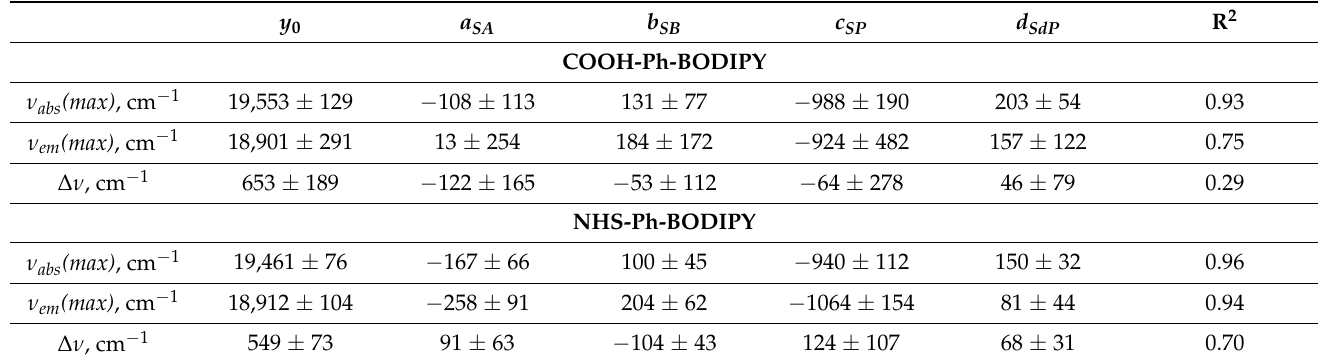
Table 2. Regression coefficients y 0 , a − d and coefficients of determination R 2 for multiple linear regression analysis of maximum absorption ν abs (max) and emission ν em (max) wavenumbers and Stokes shifts ∆ ν of COOH-Ph-BODIPY and NHS-Ph-BODIPY as a function of Catal á n solvent scale parameters { SA , SB , SP , SdP